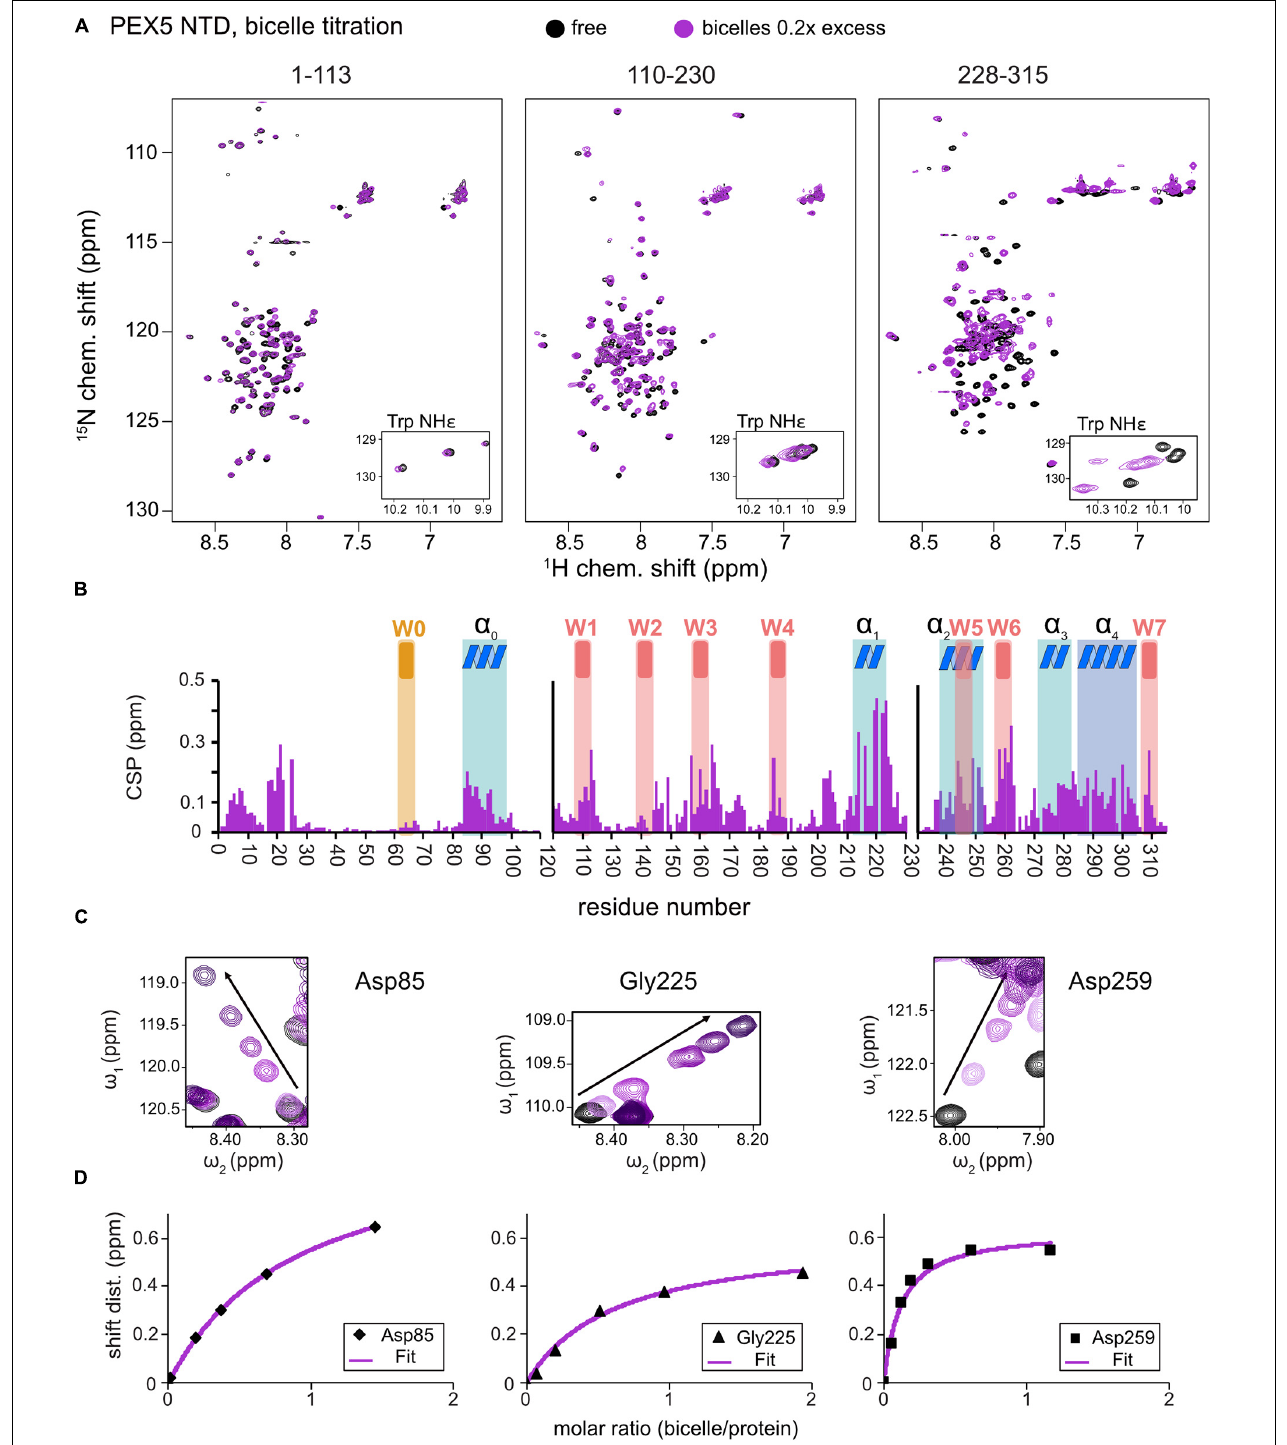
FIGURE 2 | PEX5 NTD – membrane binding. 1 H, 15 N HSQC NMR spectra overlay (A) of free PEX5 1–113, 110–230, and 228–315 (back) and in the presence of 0.2x molar excess of DMPC/D7PC bicelles with a q- value of 0.2. The subconstruct 228–315 is largely affected by 0.2x molar excess while the constructs 1–113 and 110–230 show comparable effects at a molar excess of 0.7x and 0.9x (B) . Tracing the chemical shift perturbations of largely affected residues Asp85, Gly225, and Asp259 of the subconstructs (C) and plotting shift distance against the molar ratio of bicelle to protein (D) Fitting of the NMR titration data (chemical shift difference to the free state) to a one-site binding model as a function of the molar bicelle:protein ratio (see section “Materials and Methods”).